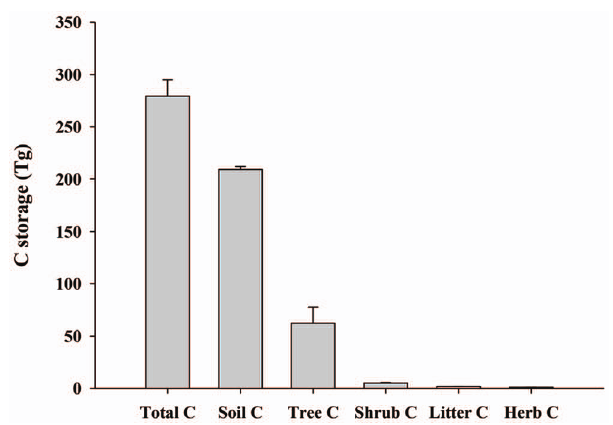
Figure 4. The C storage in different layers of forest ecosystems on Hainan Island in 2008. Tree C includes C in above- and below- ground biomass. Values are means 6 SE.